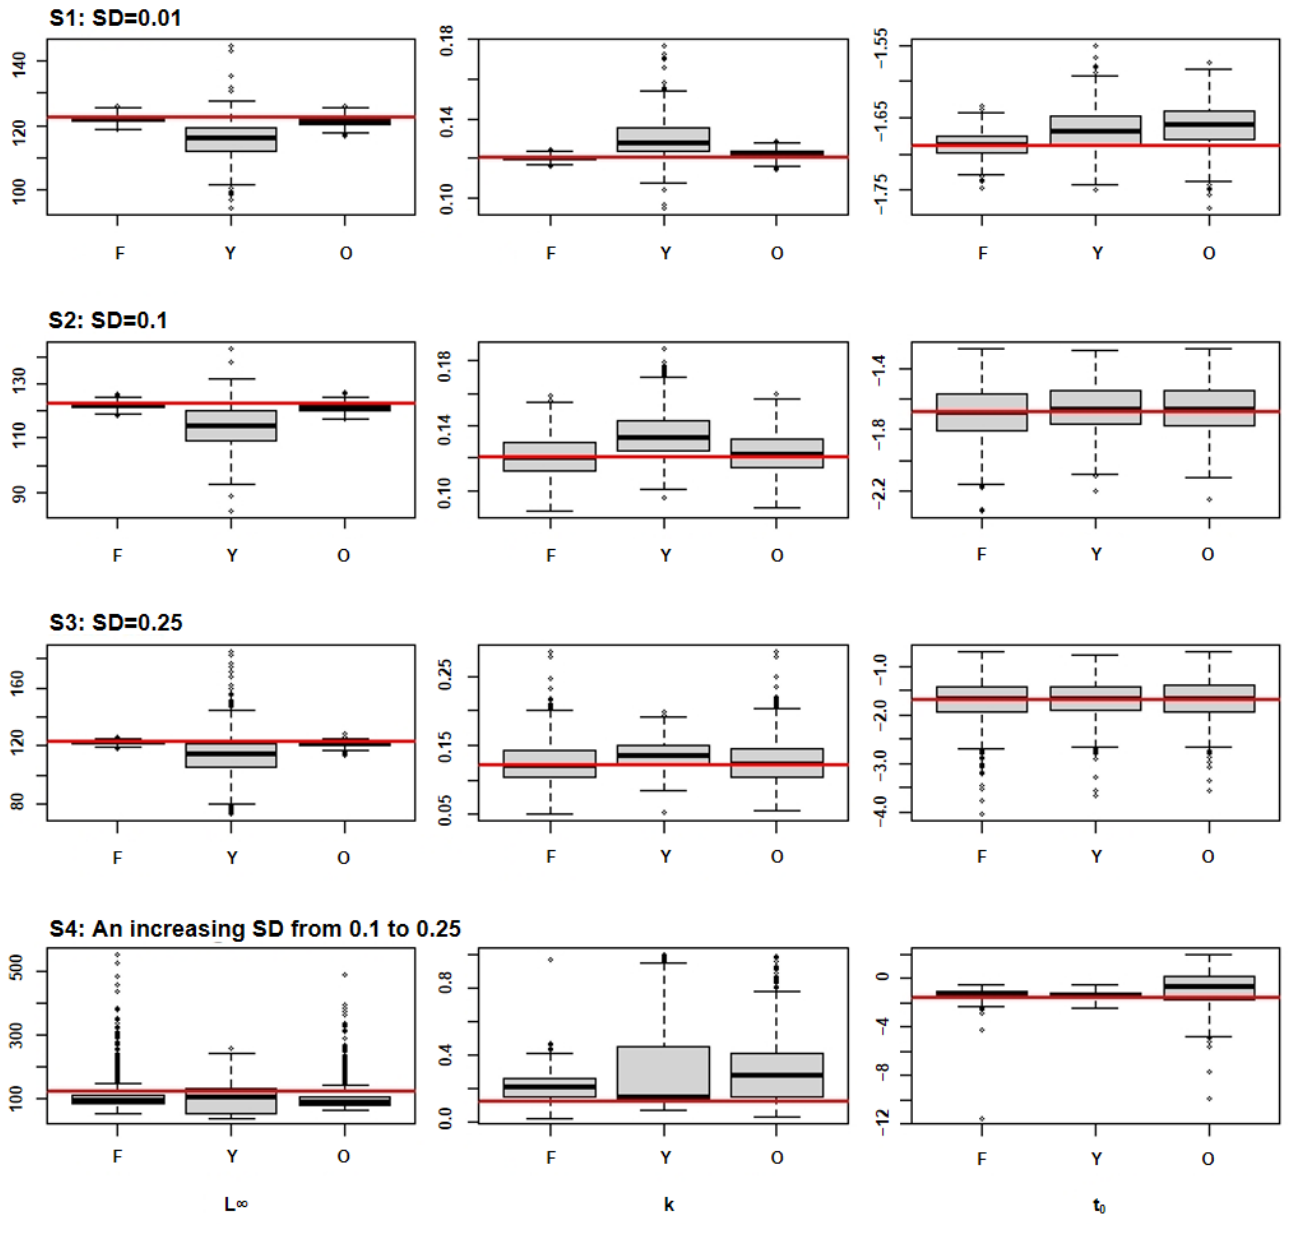
Figure 6. Distributions of estimated growth parameters of simulated skipjack tuna.